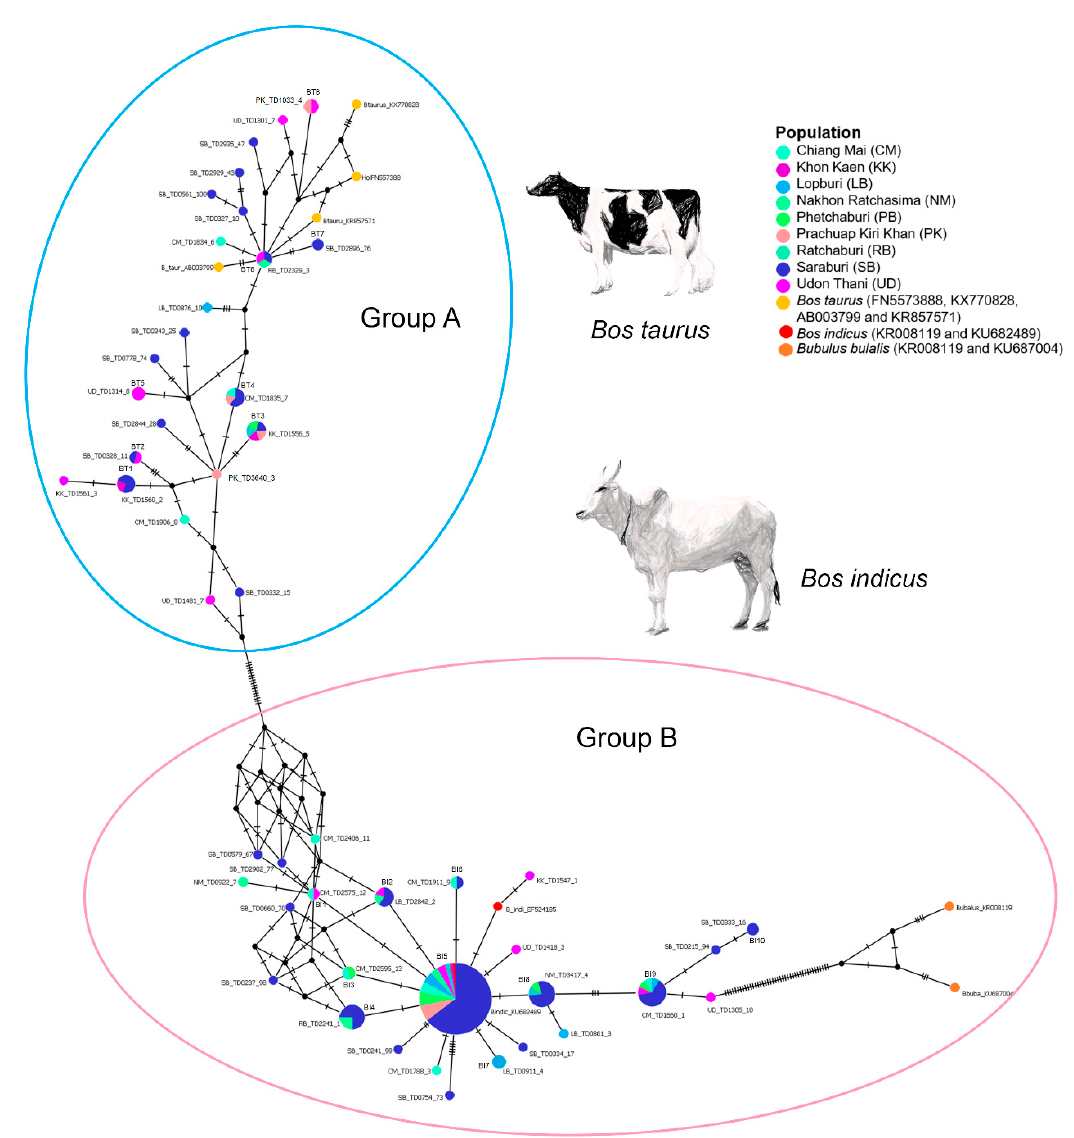
Figure 1. Haplotype network derived from nucleotide sequence data for mitochondrial D-loop of cattle ( Bos taurus ) for 187 (179 + 8) individuals. Different colors are used to distinguish the nine populations sampled. Each circle represents a unique DNA sequence (haplotype). Presumably the diameter of each circle reflects the total number of individuals possessing the haplotype. The number of individuals possessing each haplotype are indicated by different colors within the circles.